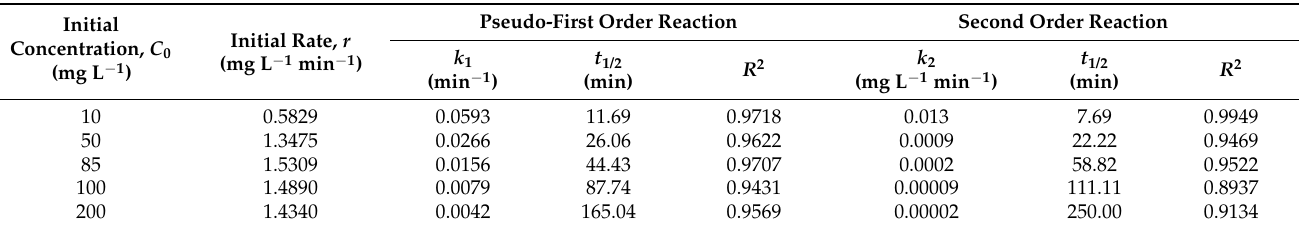
Table 3. Kinetic parameters based on the plasmonic photocatalytic reaction of Ag/AgCl under visible light using various initial concentrations of methylthioninium chloride 1 .